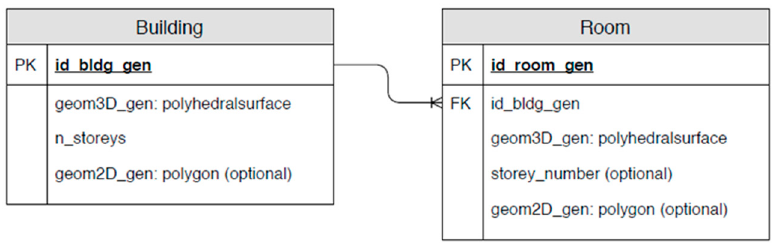
Figure 8. Database management system (DBMS) storage of the transformed procedurally generated 3D building models.